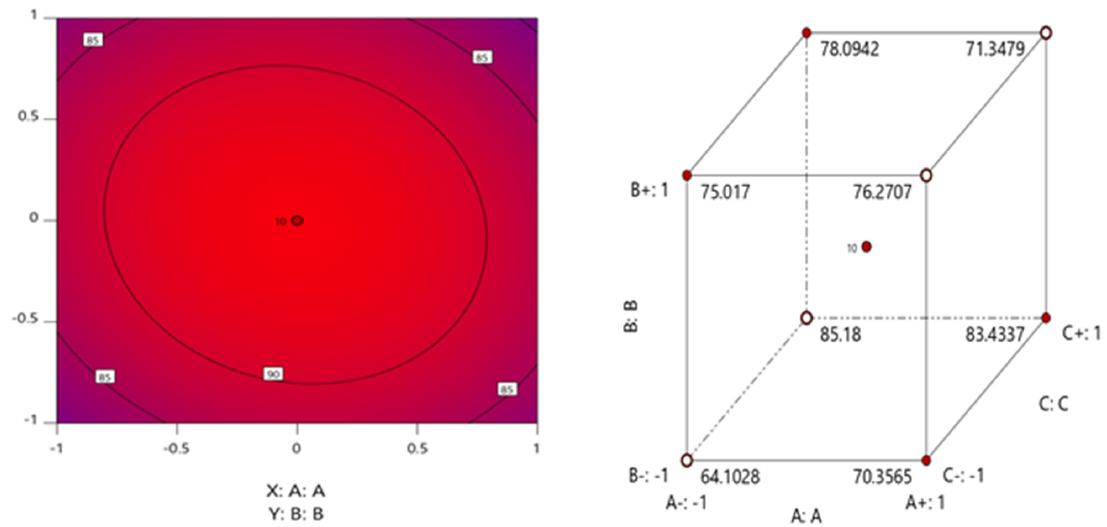
Figure 4. Contour plot representing the center-optimized point for allethrin degradation, and the cube structure representing the effects of pH ( A ), temperature ( B ), and incubation time ( C ) on allethrin degradation.